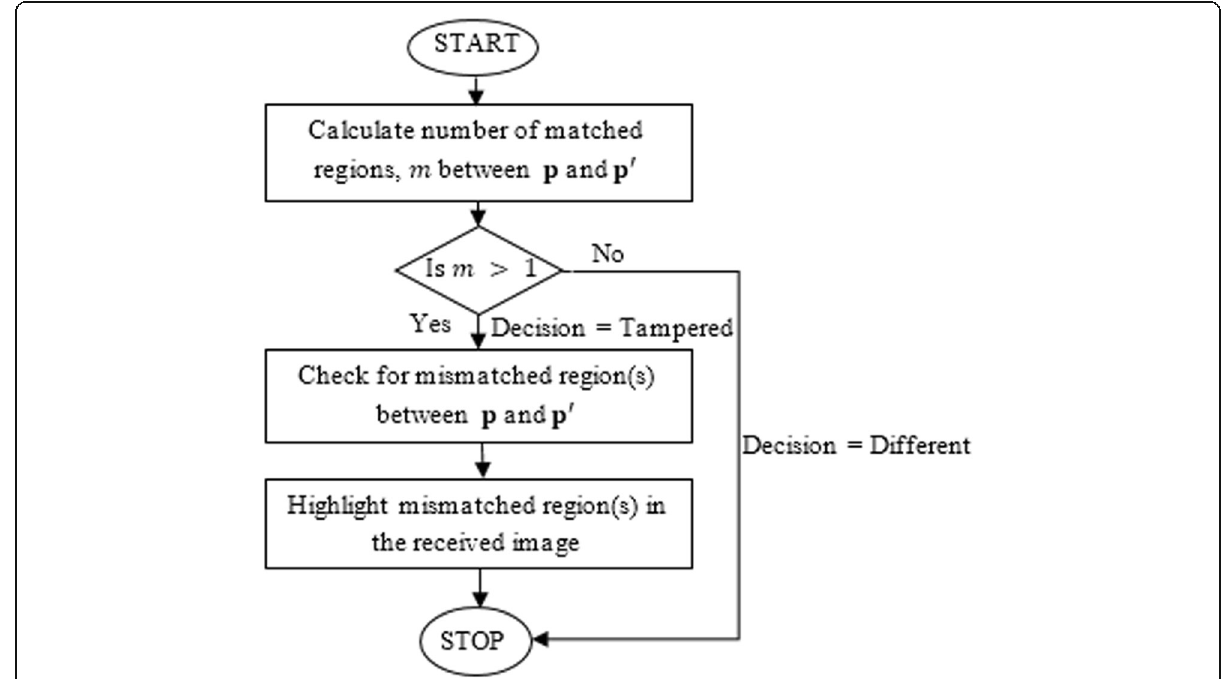
Fig. 5 Flowchart for tampered area